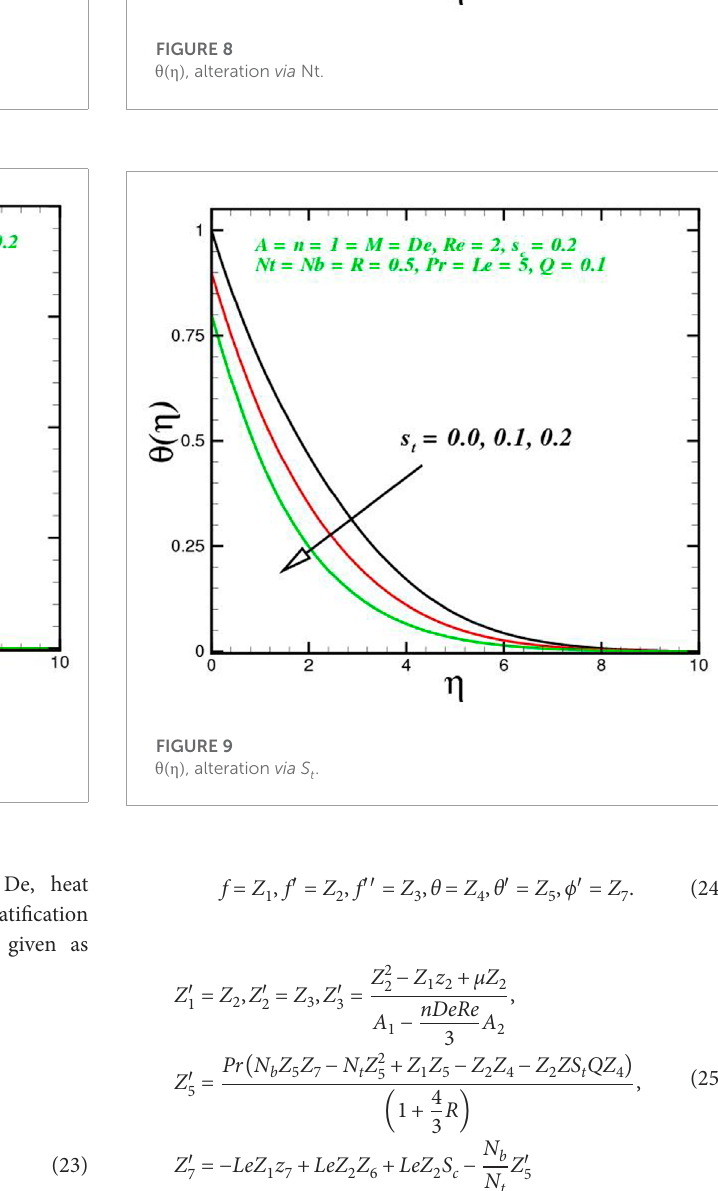
FIGURE 6 θ ( η ) , alteration via Pr.